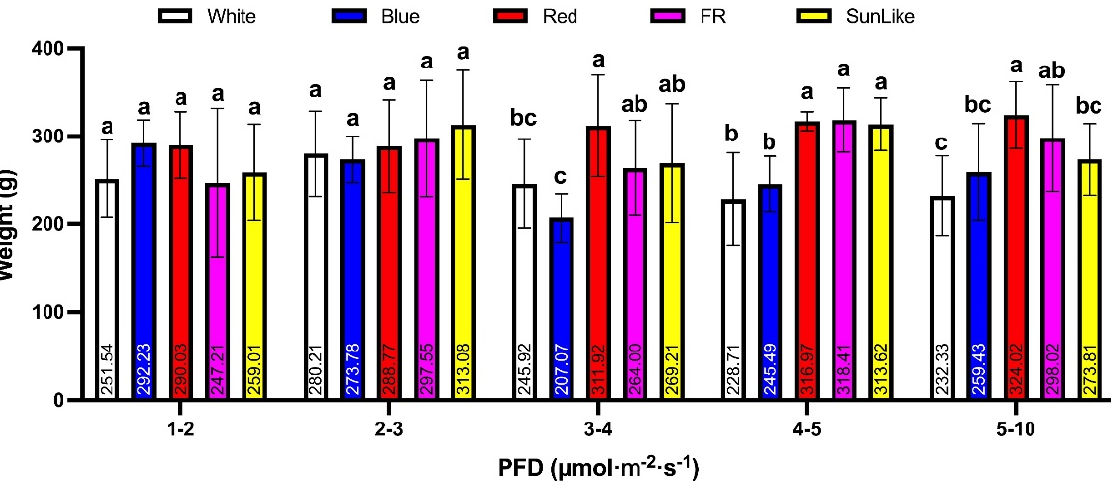
Figure 2. Effect of different light quality treatments on the yield of the fruiting bodies of P. eryngii in the same light intensity range. Different lowercase letters marked in the table indicate significant differences between treatments ( p < 0.05). The same below.